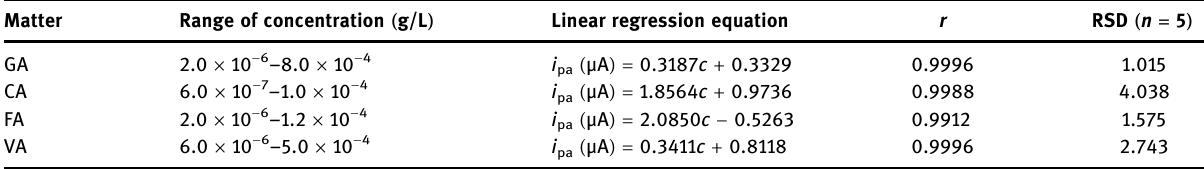
Table 3: The linear relationship between i pa and concentration of four polyphenolic compounds Matter Range of concentration ( g/L ) Linear regression equation